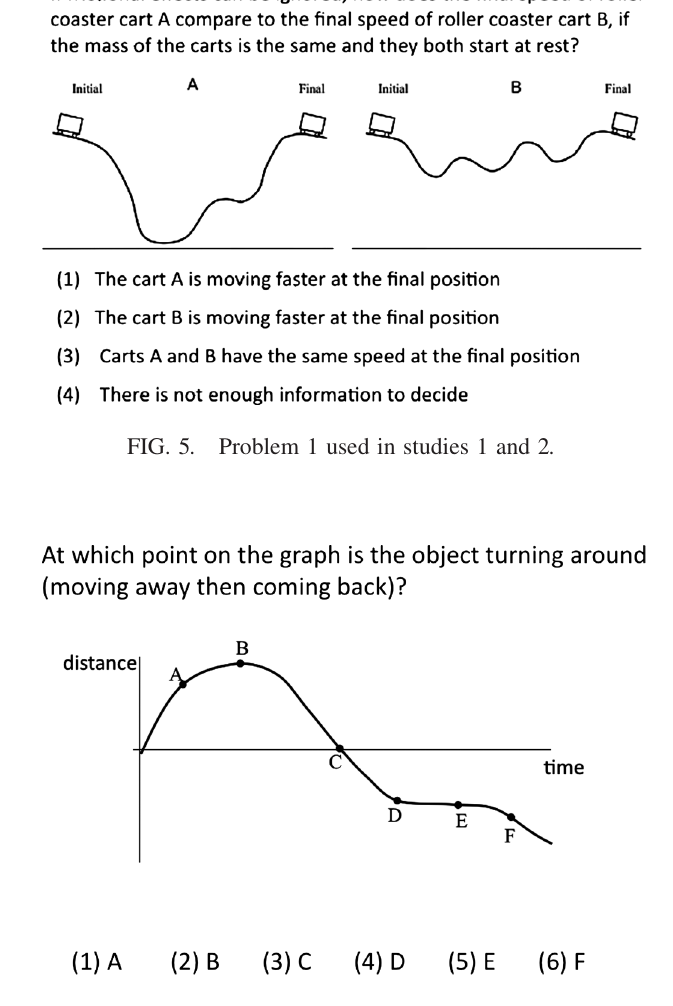
FIG. 6. Problem 2 used in studies 1 and